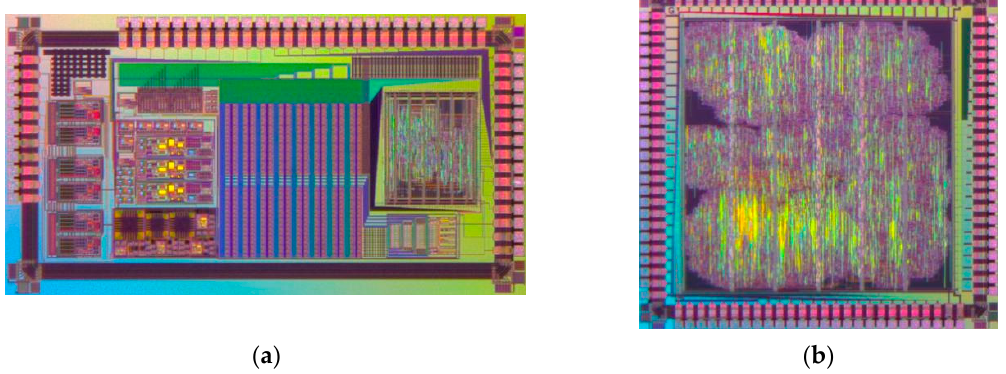
Figure 14. ( a ) Chip micrograph of analog modules; ( b ) Chip micrograph of digital modules.